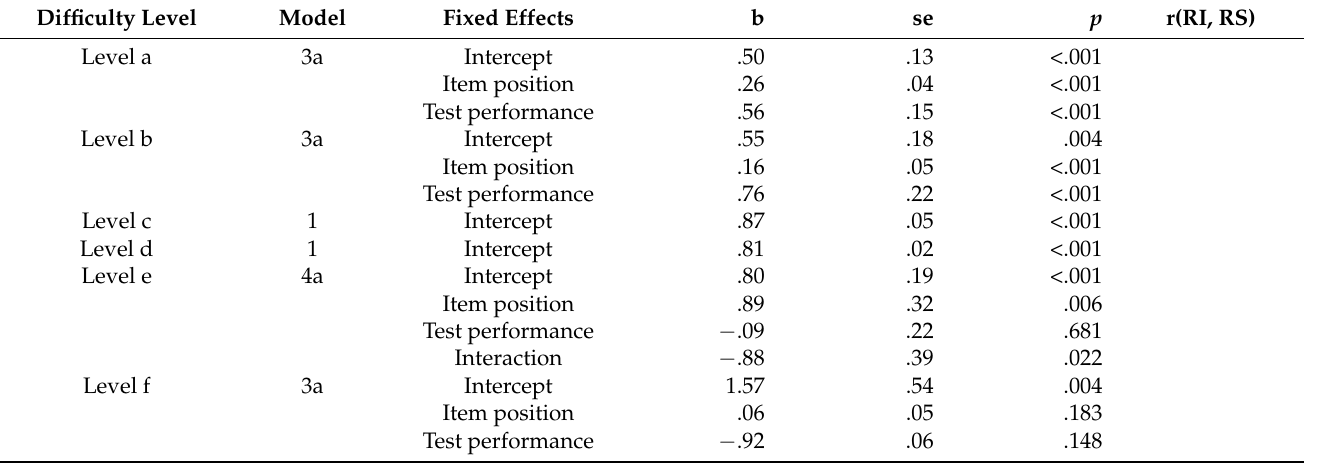
Table 9. Fixed effects and correlations between random intercept (RI) and random slope (RS) of the MLM with the dependent variable IPA (difference between both